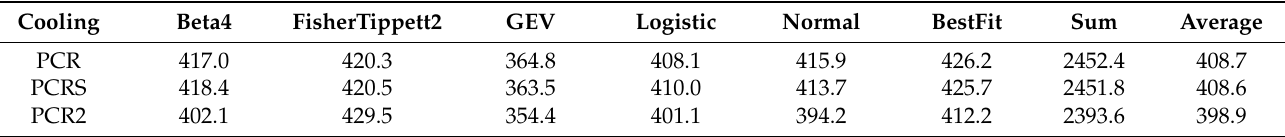
Table 5. Results of the mean absolute errors of cooling energy use probability density functions stemming from each input principal component variable distribution series for PCR, PCRS and PCR2 regression models.